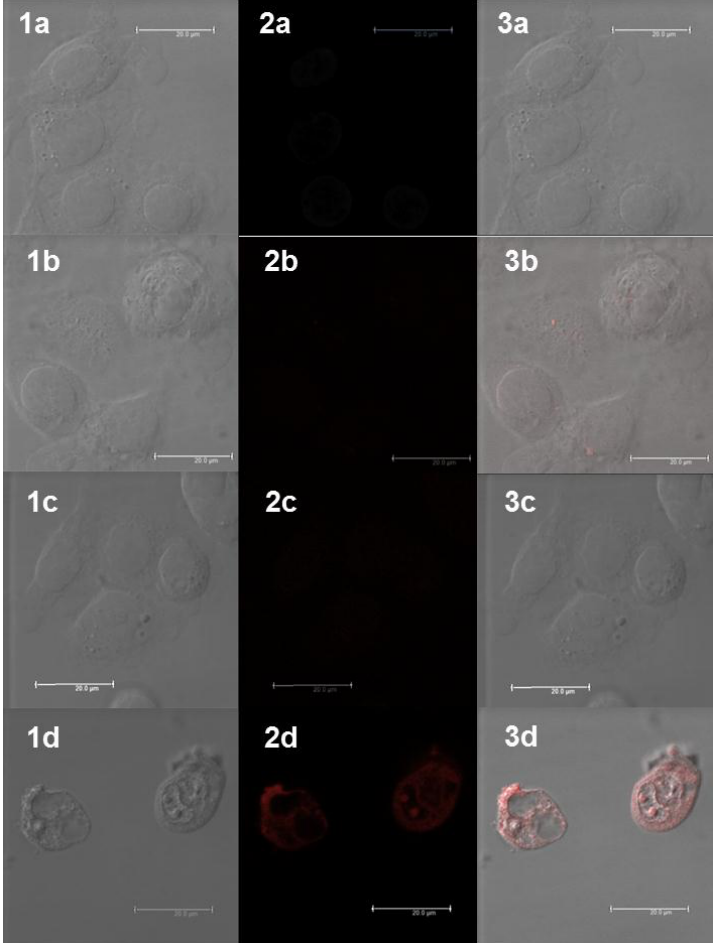
Figure 4. Confocal fluorescence microscopic images of CAL-33 cells incubated with Gd(III) complexes or conjugate for 4 h: ( 1a ) DIC (differential interference contrast) image of the untreated Cal-33 cells; ( 2a ) visualisation of background fluorescence in untreated CAL-33 cells using the excitation/emission wavelength settings (hybrid 1 channel) employed for detection of the Gd(III) compounds; ( 3a ) merged image of the DIC and hybrid 1 channel images of untreated cells; ( 1b ) DIC image of the CAL-33 cells treated with 100 μM of “clicked” Gd-L; ( 2b ) visualisation of “clicked” Gd-L in cells; ( 3b ) merged image of the DIC and hybrid 1 channel images of cells treated with “clicked” Gd-L; ( 1c ) DIC image of the CAL-33 cells treated with 100 μM of Gd-L; ( 2c ) visualisation of Gd-L in cells; ( 3c ) merged image of the DIC and hybrid 1 channel images of cells treated with Gd-L; ( 1d ) DIC image of the CAL-33 cells treated with 100 μM of Gd-L-Tat peptide conjugate; ( 2d ) visualisation of Gd-L-Tat peptide conjugate in cells; ( 3d ) merged image of the DIC and hybrid 1 channel images of cells treated with Gd-L-Tat peptide conjugate. The scale bars represent 20 μm.